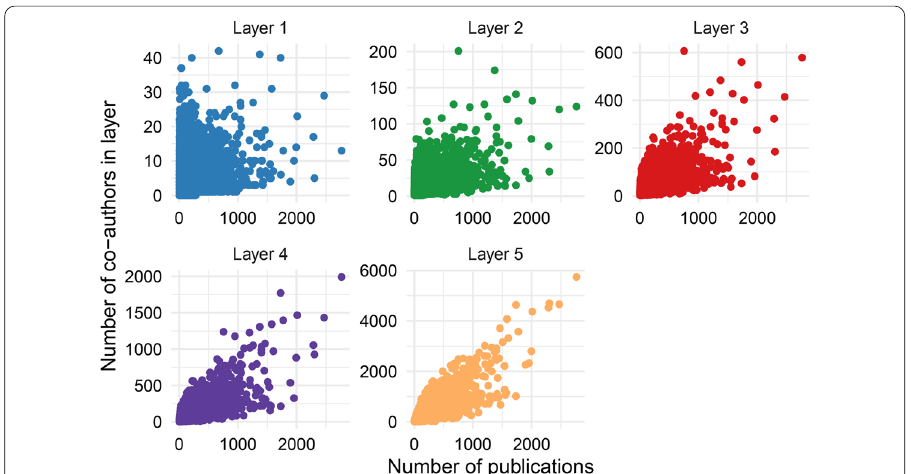
Fig. 9 Productivity and co-authorship ego networks. Scatterplot of ego network layer size versus number of